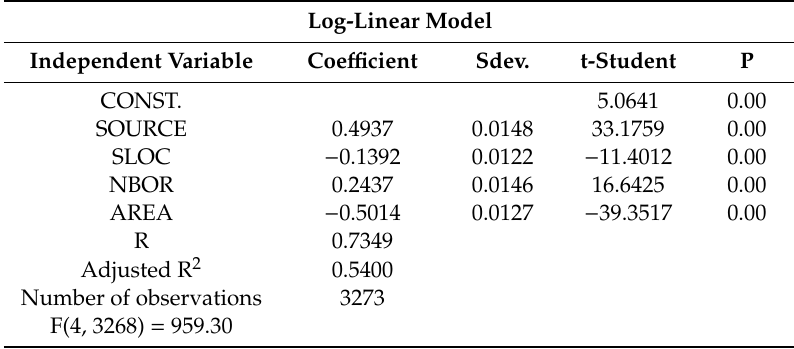
Figure 4. Distribution of the expected value of the DIFFabs. discrepancy model relative to the measured values. Source: own study on Statistica 13.1. Table 4. Modelling